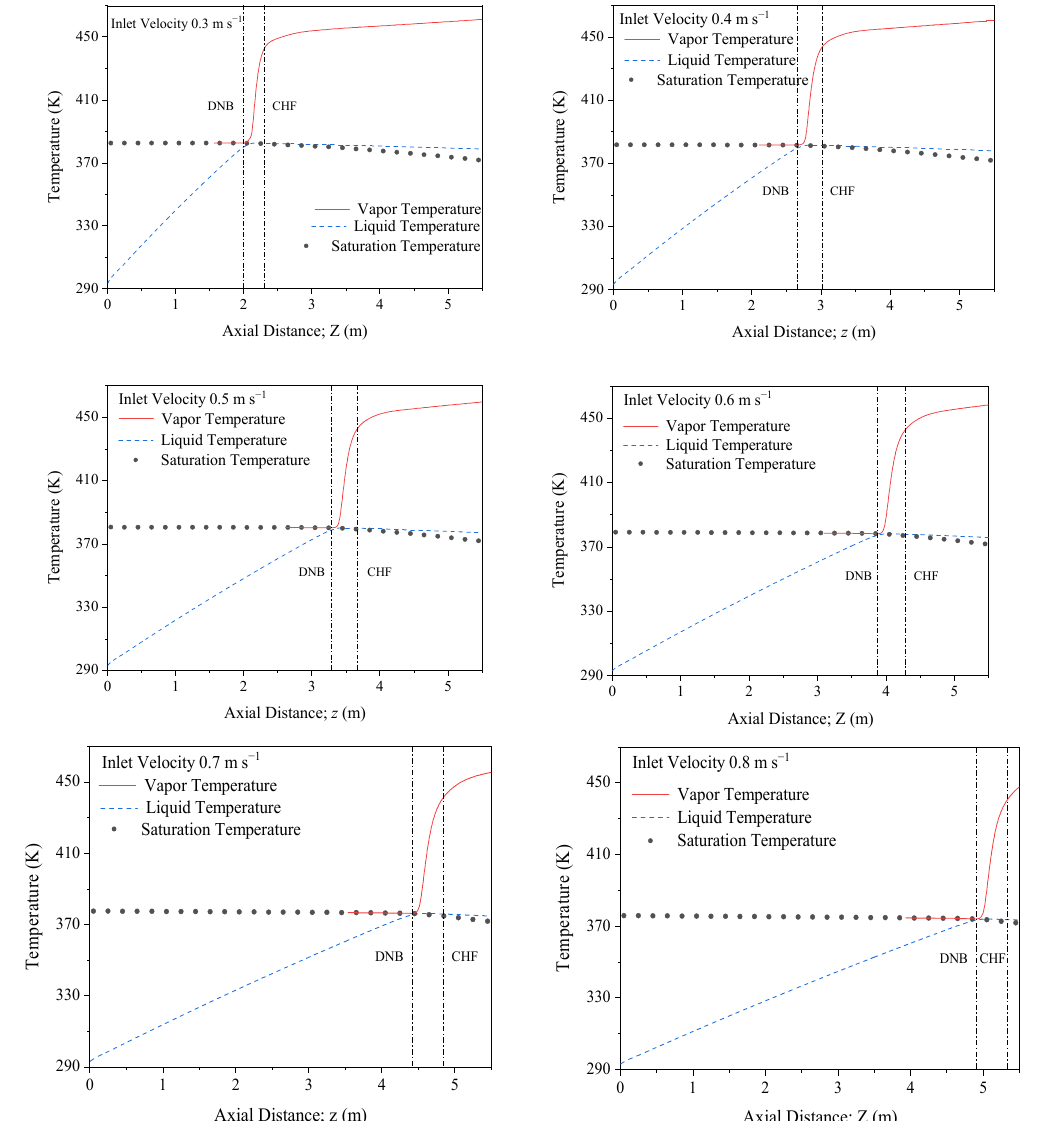
Figure 21. Distributions of average vapor temperature, average liquid temperature and local saturation temperature along the axial direction at inlet velocities ranging from 0.3 m·s − 1 to 0.8 m·s − 1 . Since the pressure drop in the single-phase convection region is much smaller than that in the boiling region, the saturation temperature gradually decreases along the axial direction in the boiling region. However, it is almost unchanged in the single-phase convention region. It can be seen from Figures 21 and 22 that the vapor phase temperature is kept at the saturation temperature in the nucleate boiling region. When the DNB occurs, the superheated wall starts to heat the vapor phase directly, and the vapor temperature rises dramatically as a consequence. This dramatic rise in the vapor temperature continues until the CHF appears. In the post-CHF region, the increase in the vapor temperature decreases gradually and tends to stay in a fixed value, which results in a moderately linear increase in vapor temperature in the DFFB